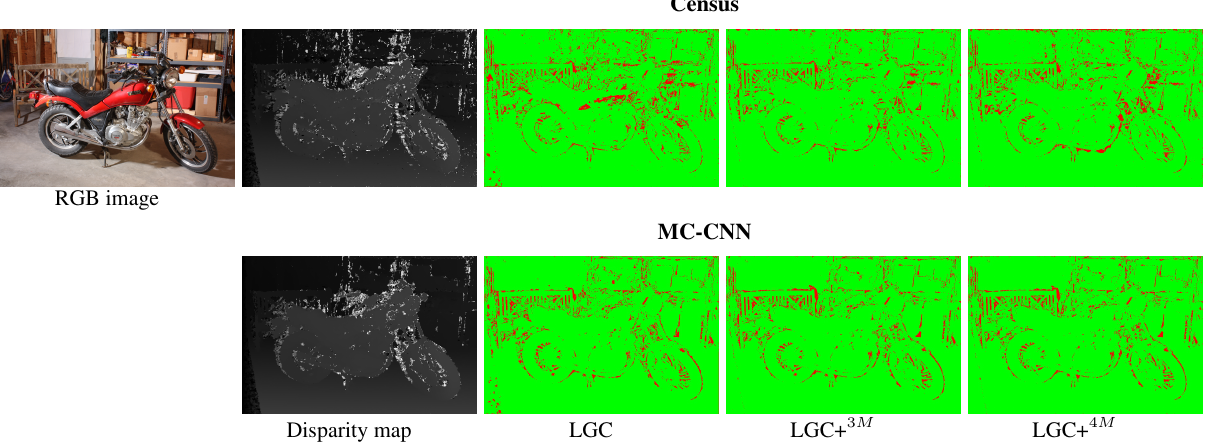
Figure 3. Qualitative evaluation regarding the generalisation capabilities of the proposed approach on the Middlebury v3 dataset (Scharstein et al., 2014). For details on colour coding, please refer to Figure